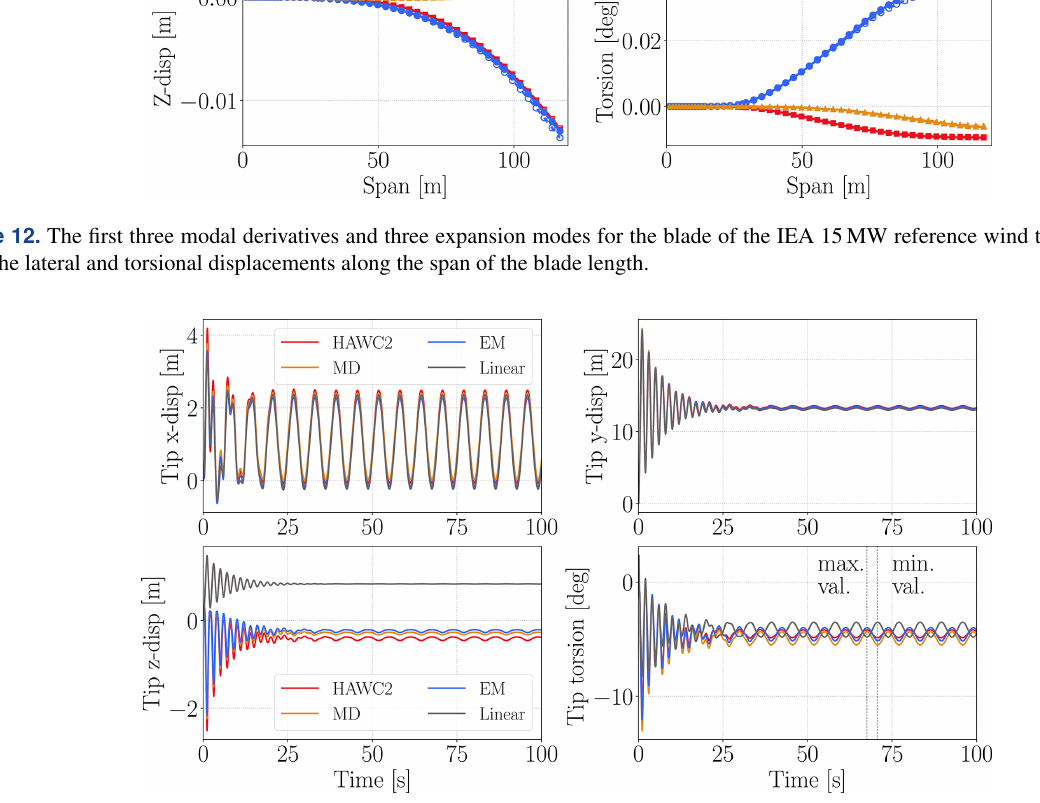
Figure 13. The lateral and torsional displacements for the blade tip of the IEA 15MW wind turbine obtained by using HAWC2, the linear ROM, MD correction and EM